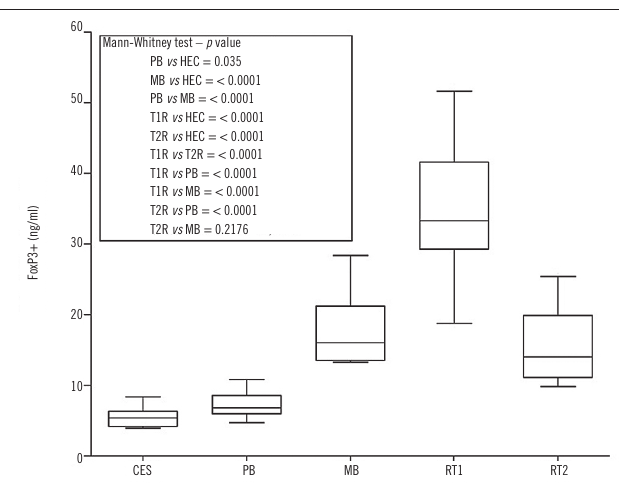
Mann-Whitney test – p value PB vs HEC =